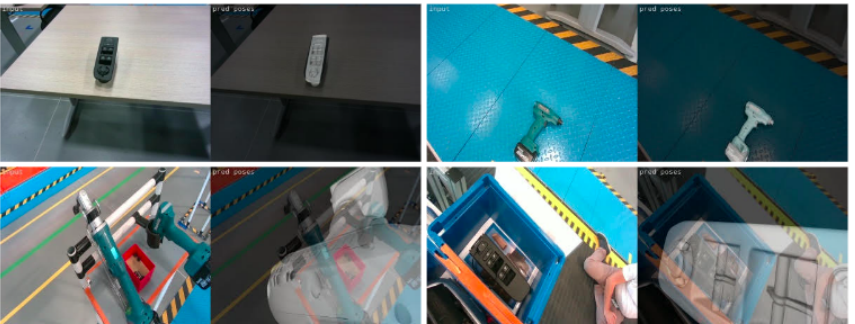
Figure 15. Test results for the model trained on laboratory data. The first row illustrates correct predictions in cases of homogeneous background, while the second row illustrates cases of incorrect predictions due to complex